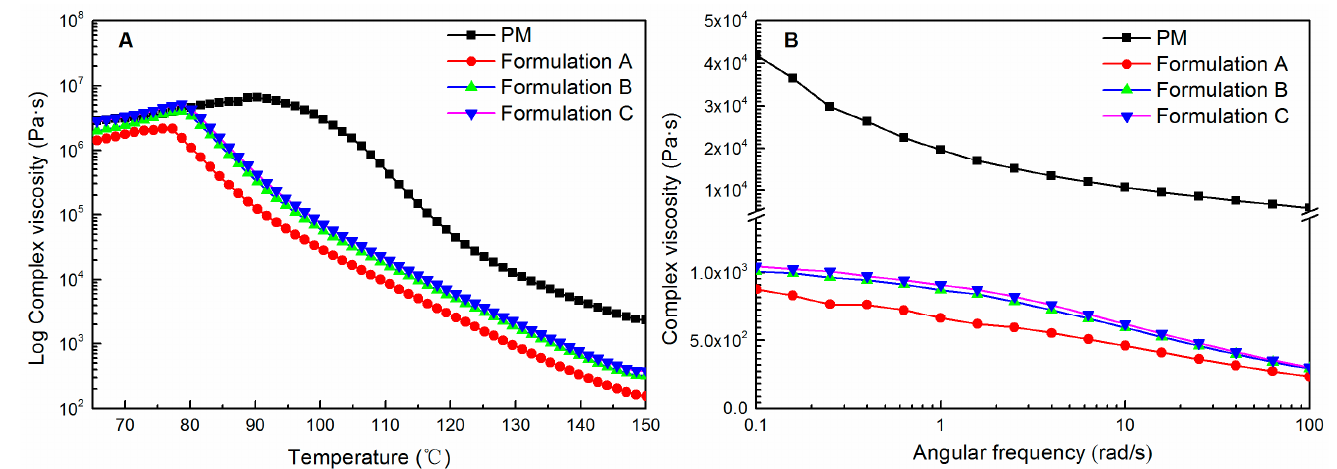
Figure 9. The temperature sweeps ( A ) and frequency sweeps ( B ) of the extrudates. (PM: physical mixture of ritonavir/PVPVA/Span 20).